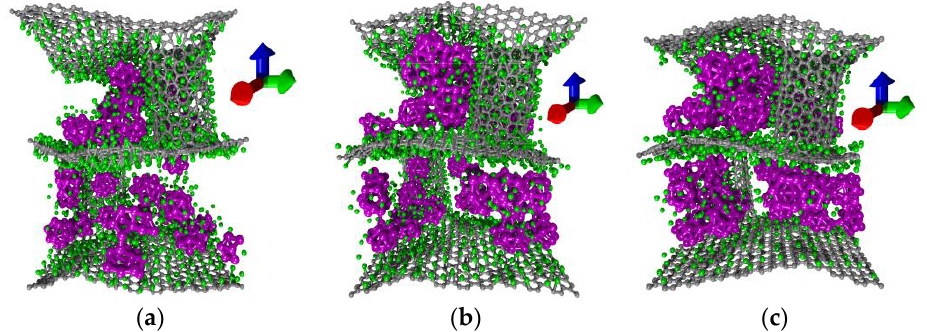
Figure 3. Lithiation of anode material on the example of model I with: ( a ) with 18 clusters of Si16; ( b ) with 36 clusters of Si16; ( c ) with 59 clusters of Si16.